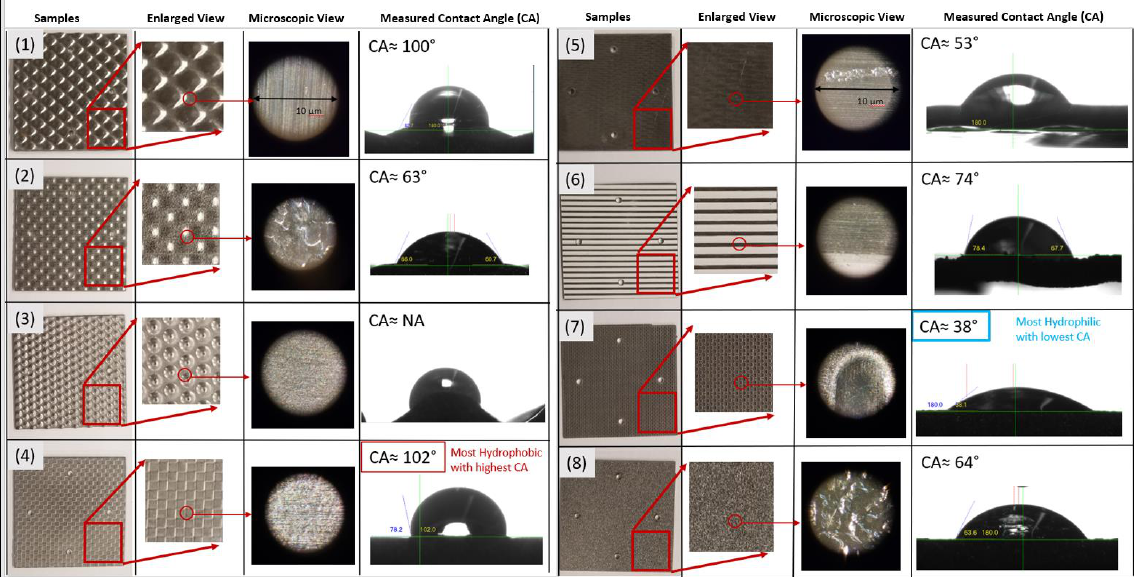
Figure 5: Photograph and enlarged view of the samples, microscopic view, measured contact angle. All the microscopic view has same scale of 10 μ m. Except for the contact angles that were screen shot directly in computer, all the photographs were taken with the camera of Samsung Note 2.